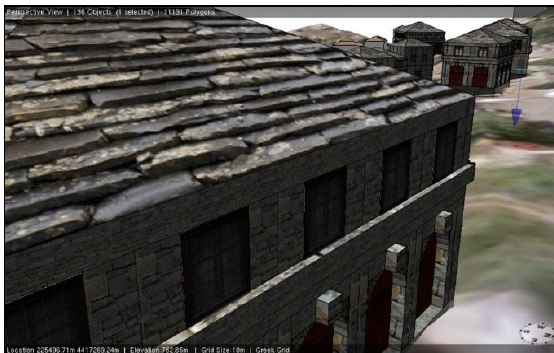
Figure 11. Detail of generated window ledge